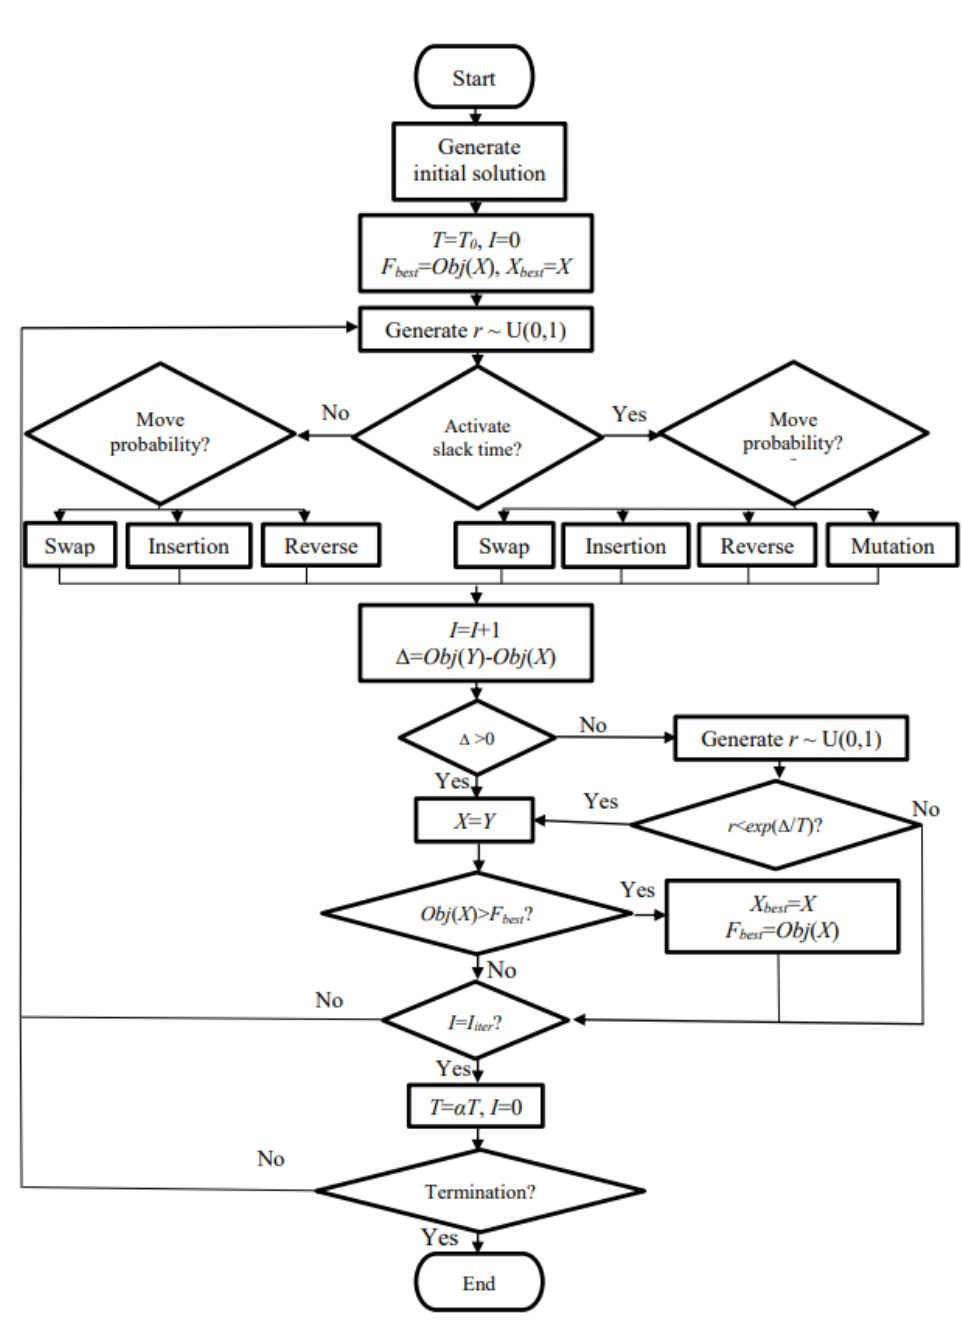
Figure 4. A flowchart of Simulated Annealing with Mutation Strategy (SAMS).